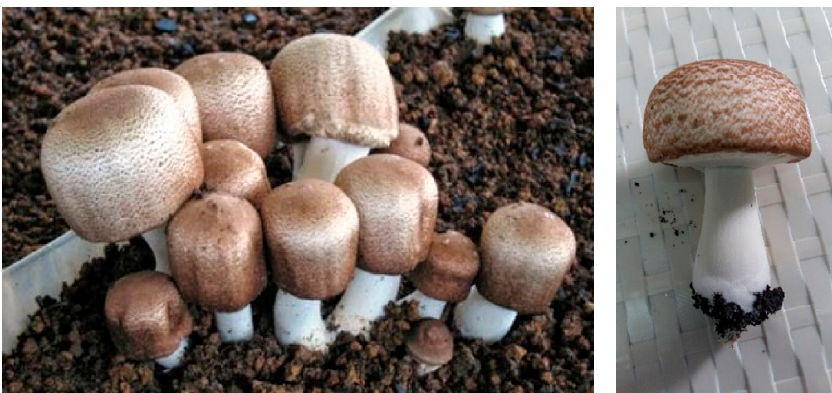
Figure 8. Agaricus blazei Murrill mushrooms. Source: Photo original—SC CIUPERC Ă RIA SRL, Aghiresu-Fabrici, Cluj County.